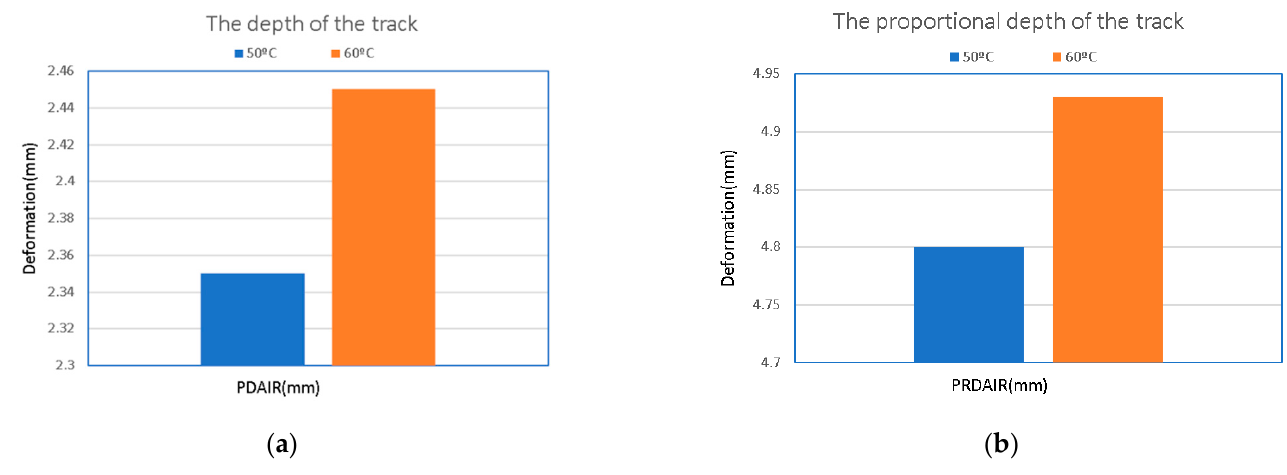
Figure 10. Resistance tests at 50 °C and 60 °C for ( a ) RDAIR and ( b ) PRDAIR.